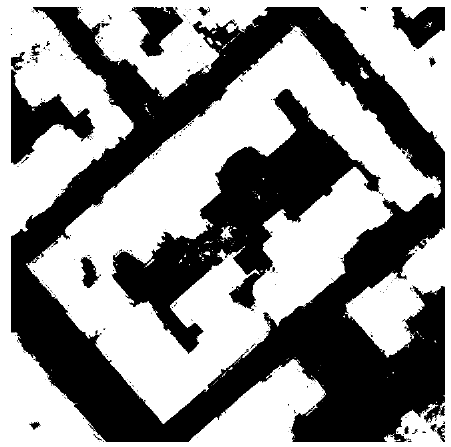
Fig. 2 The n DSM elevation data of the AOI.